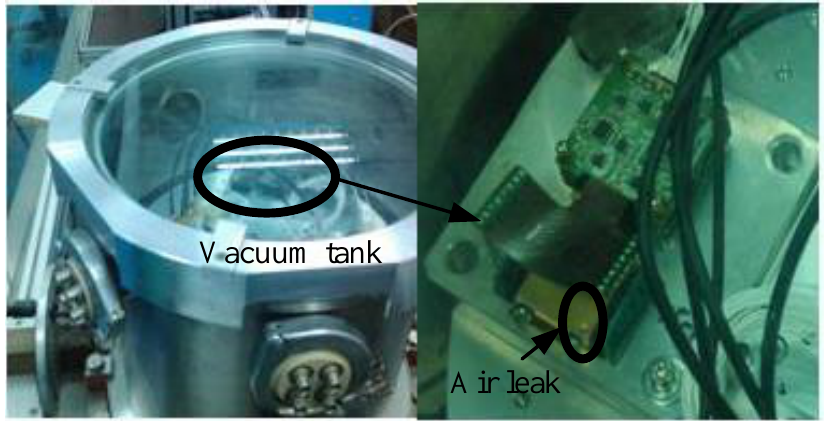
Figure 1. Photo of the experimental setup, showing the vacuum chamber and the MEMS gyroscope with an air leak.